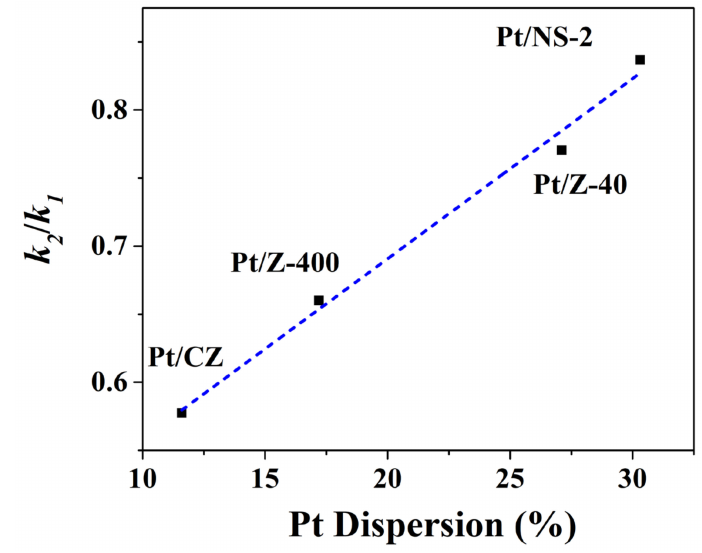
Figure 10. Correlation between the Pt dispersion and the k 2 / k 1